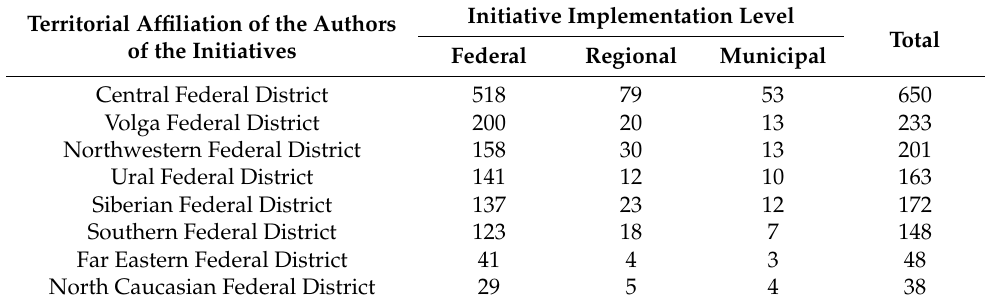
Table 2. The number of public initiatives by territorial affiliation of the initiative authors and by the levels of implementation (data from the “Russian Public Initiative” Internet platform, March 2020–March 2021) (number of initiatives and